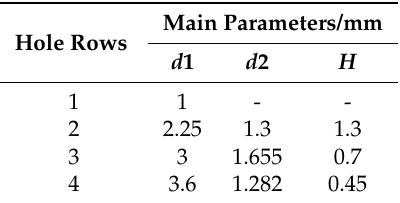
Table 4. Main film-hole configuration parameters of DD6 specimens.